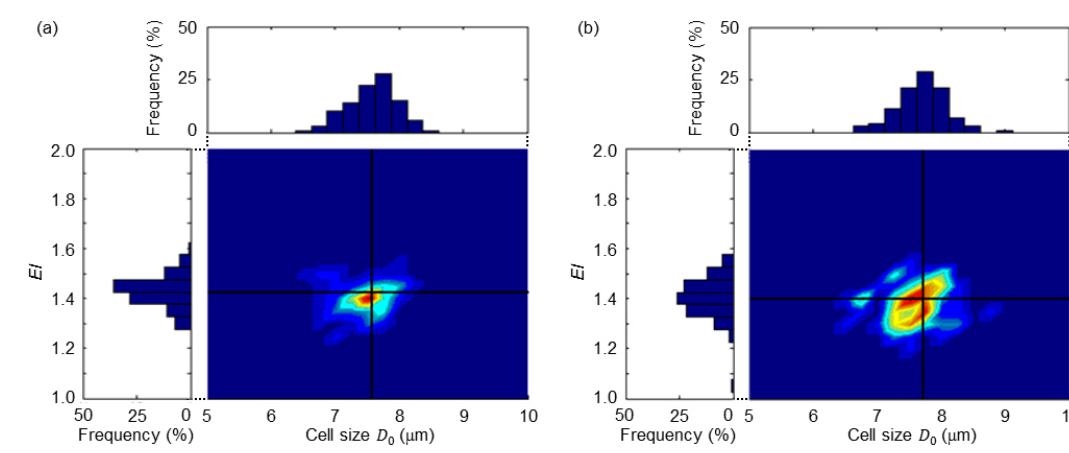
Figure 7. Extensibility map for the same blood. ( a ) Positioning resolution: ± 240 nm; ( b ) positioning resolution: ± 1200 nm.